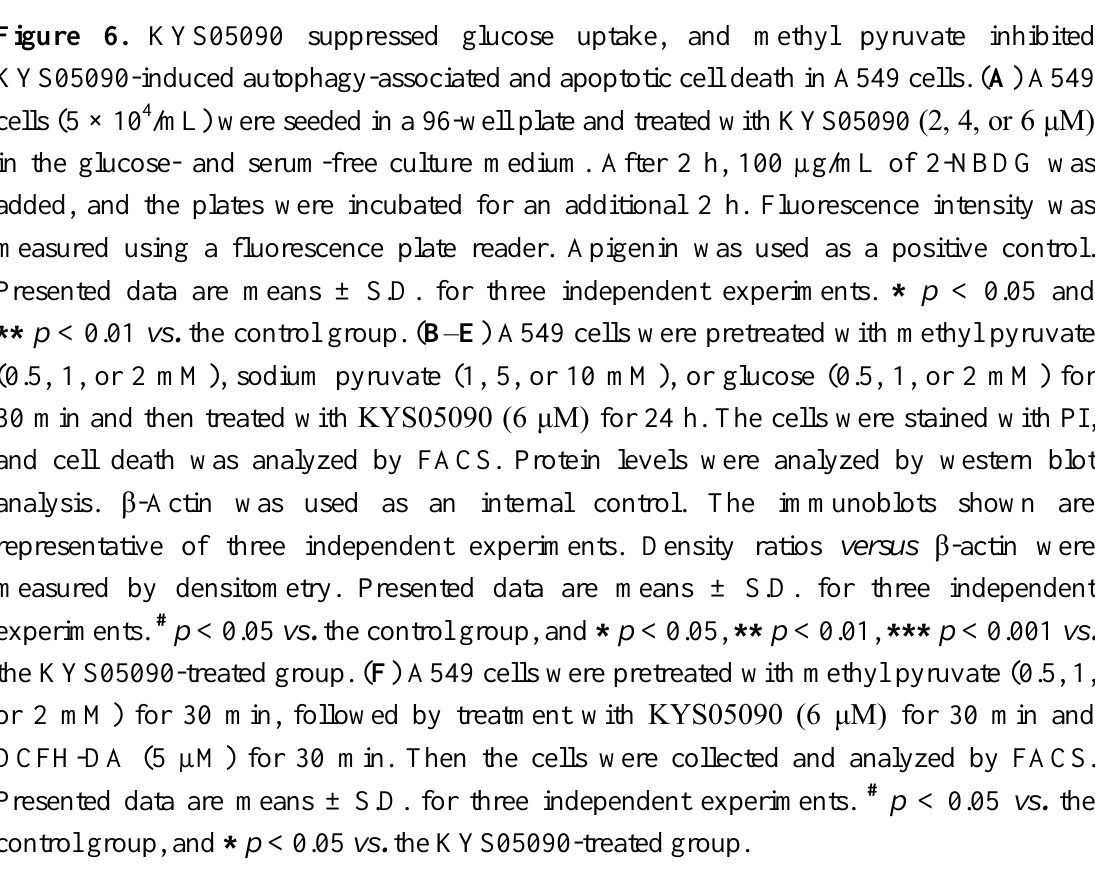
Figure 6. KYS05090 suppressed glucose uptake, and methyl pyruvate